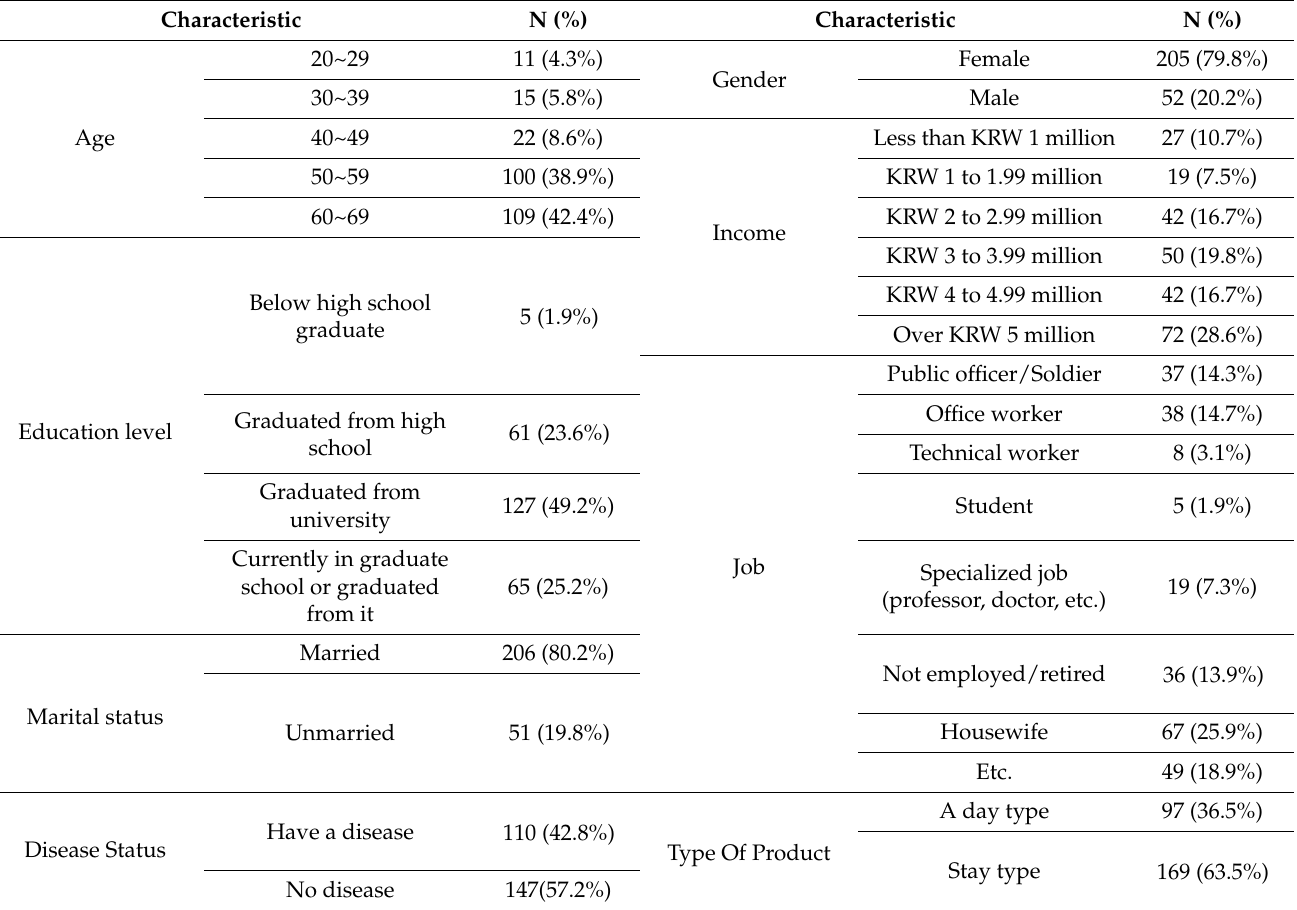
Table 5. Result of Frequency